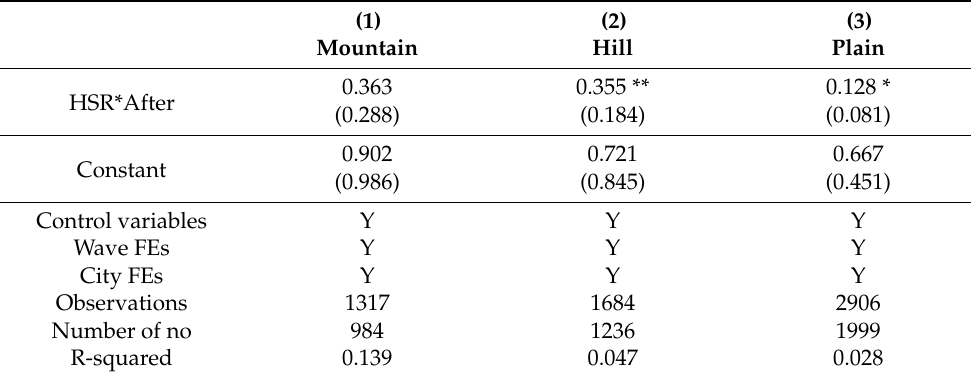
Table 6. HSR and cropland abandonment: regional